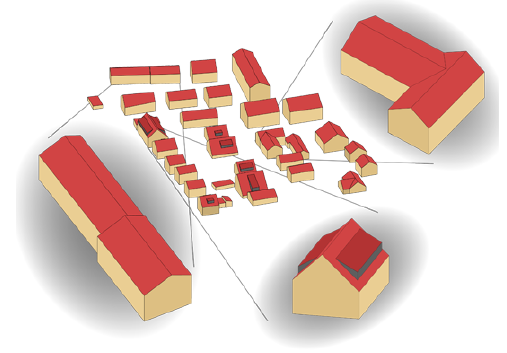
Figure 4. 3D roof models as result of an active sampling based reconstruction. Selected buildings with sophisticated roof models are highlighted.